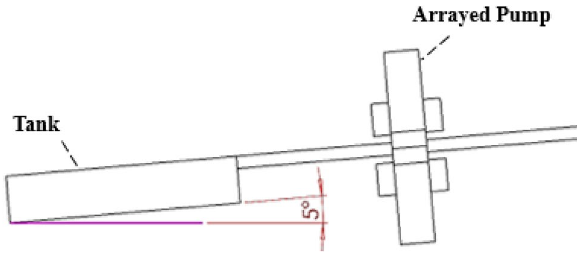
Fig. 20 The angle of the reservoir and pump with the